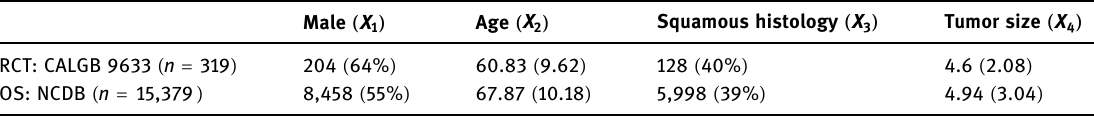
Table 3: Baseline characteristics of the CALGB 9633 trial sample and the NCDB sample; mean ( standard deviation ) for continuous and number ( proportion ) for binary covariate